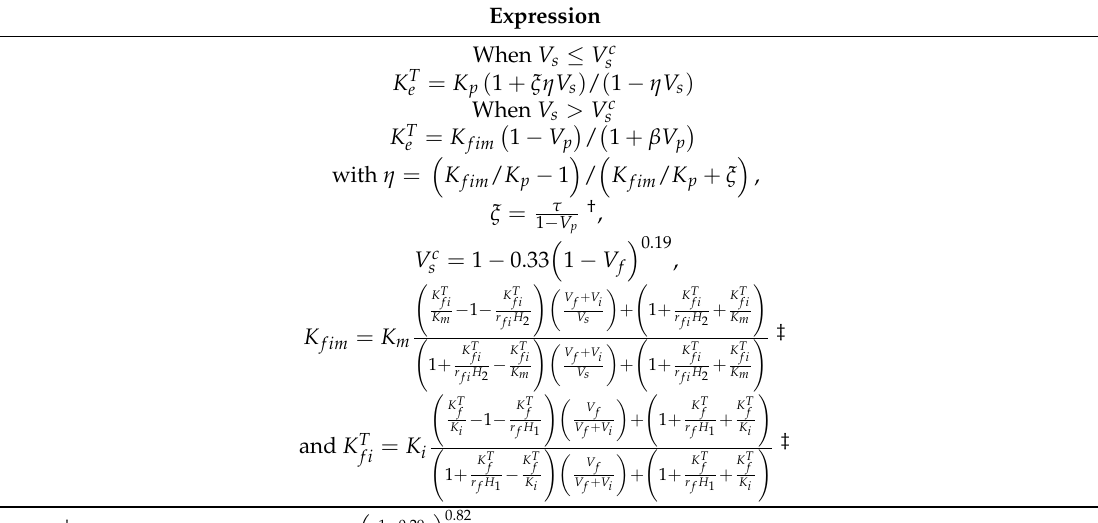
Table 1. The analytical model for transverse thermal conductivity of unidirectional composites during the CVI process.